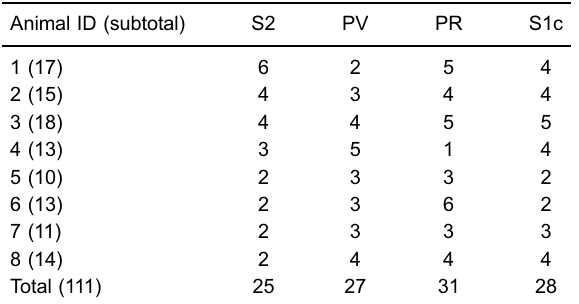
Figure 1 . Photomicrographs of anterograde labeling of corticocortical axons after a single iontophoretic injection of BDA in S1. A , Low- power photomontage ( (cid:1) 20 objective virtual slide) of an entire coronal section showing the location of a typical injection site in area S1 (arrow) and of target areas containing antero- gradely labeled axons. Below, photomicrographs with variable magni fi cations illustrating antero- gradely-labeled axons originating in S1 and terminating within the second somatosensory area (S2), the parietal-ventral area (PV), the parietal-rhinal area (PR), and the contralateral S1 (S1c). Insets show branches with boutons terminaux and en passant . Scale bars are indicated for each